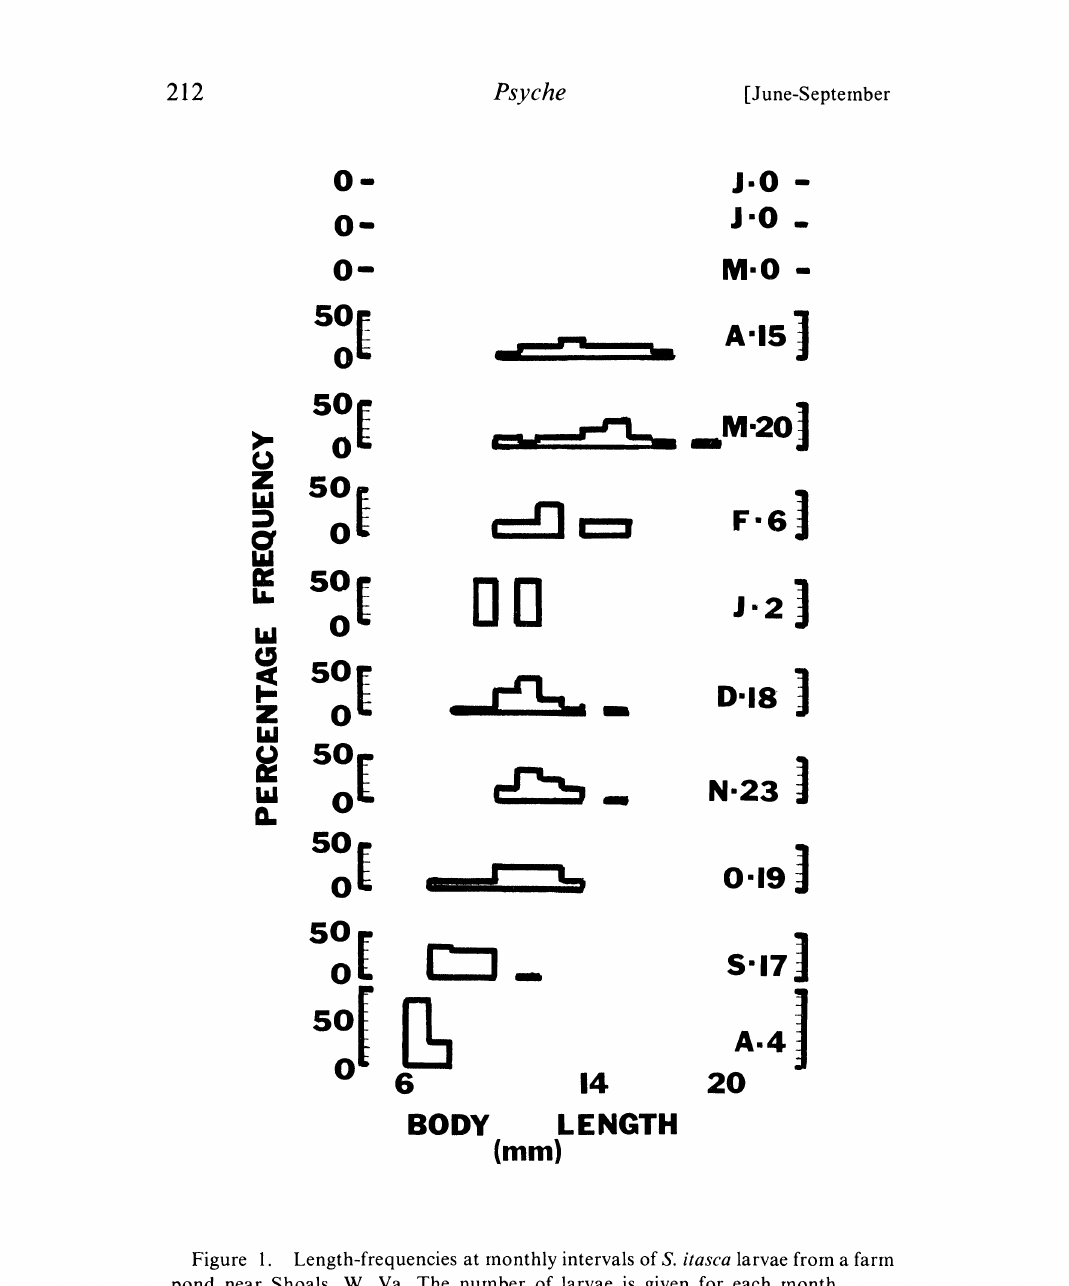
Figure 1. Length-frequencies at monthly intervals of S. itasca larvae from a farm pond near Shoals, W. Va. The number of larvae is given for each